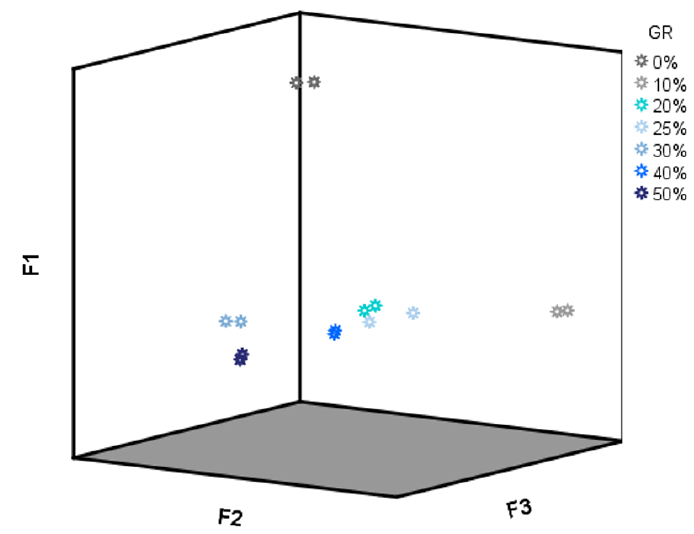
Figure 6. F1, F2 vs F3 score plot